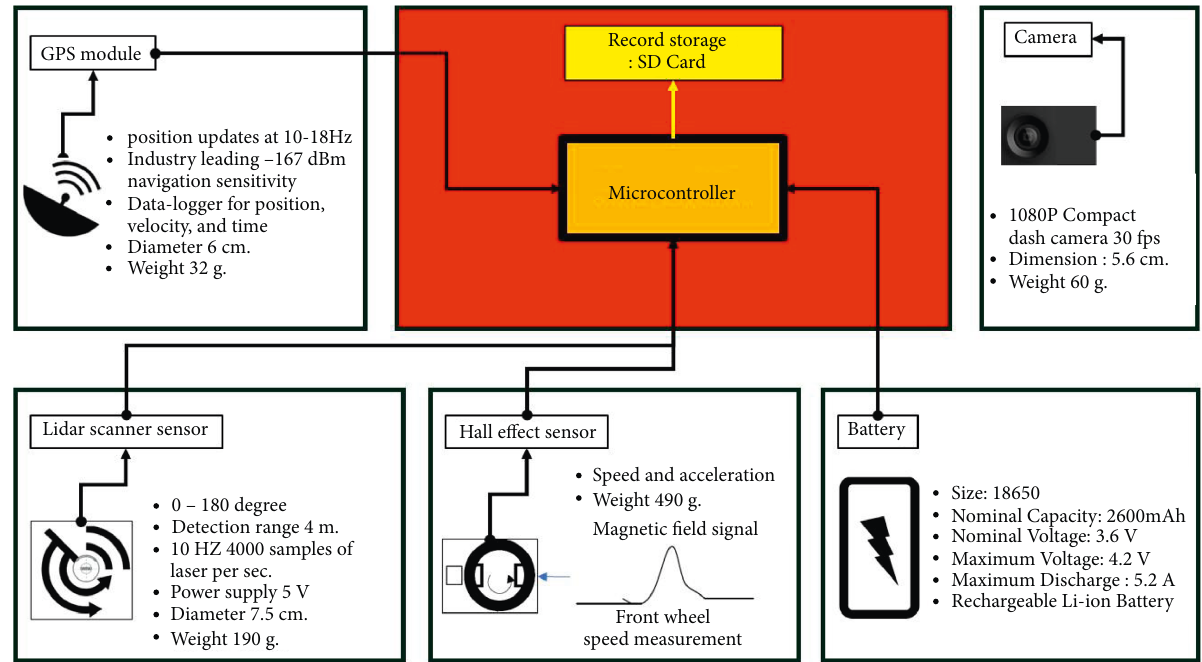
Figure 2: Working diagram of the developed onboard measurement device.